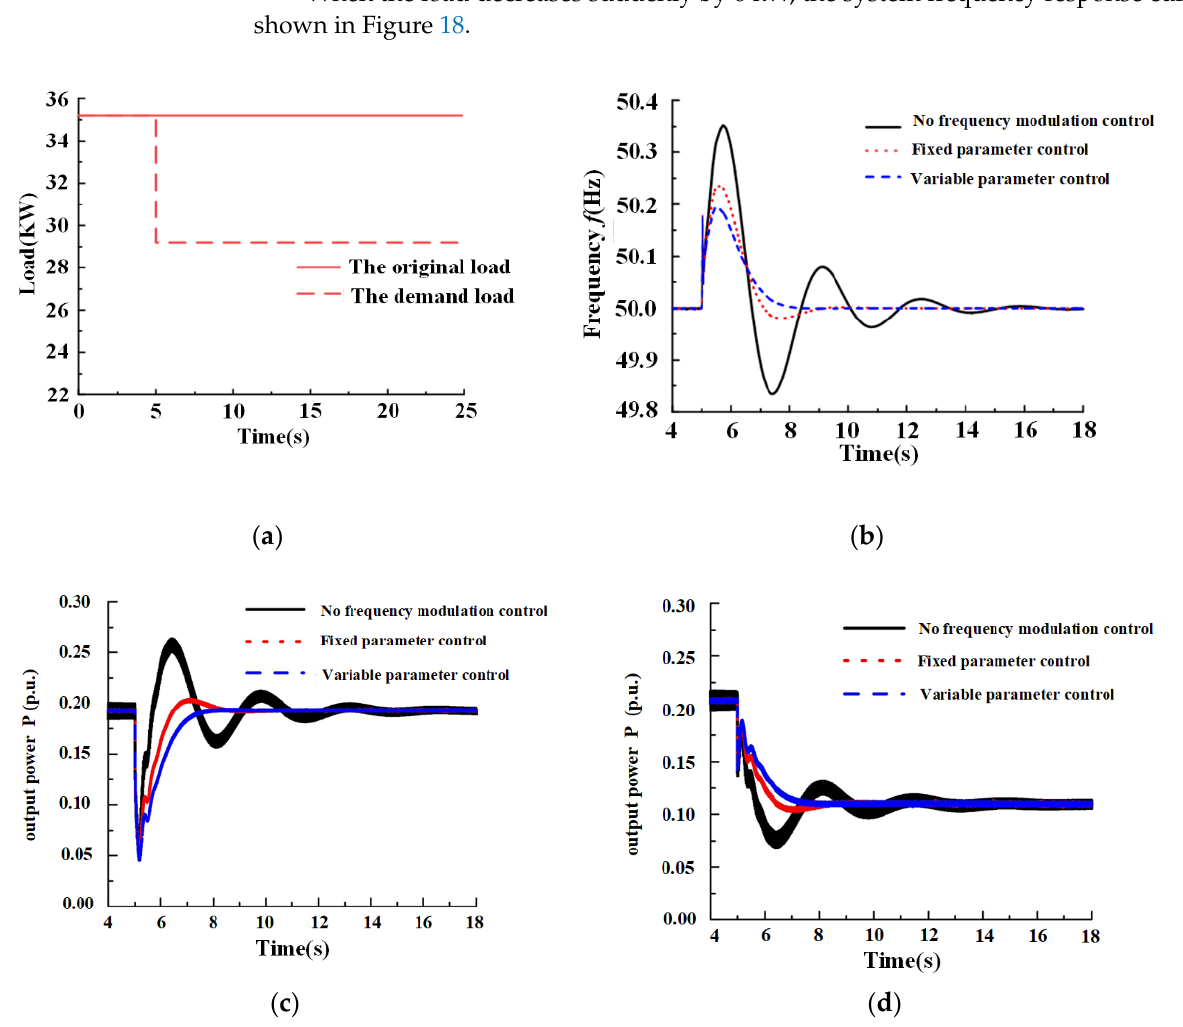
( d ) Figure 17. Rotor combined with energy storage frequency modulation simulation response curve. ( a ) The rotor-speed response curve. ( b ) Transmission power output curve. ( c ) Accumulator power output curve. ( d ) Power input to generator curve. After the combined wind turbine and energy storage frequency modulation control strategy is introduced, the rotor adopts the method of reducing the rotational kinetic en- ergy to provide energy for the generator, and the energy change caused by the change in